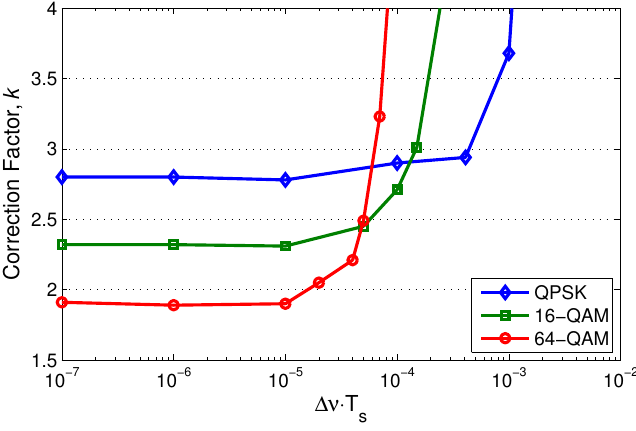
Figure 3. Correction factor, k , for different modulation formats at the target BER of 10 − 3